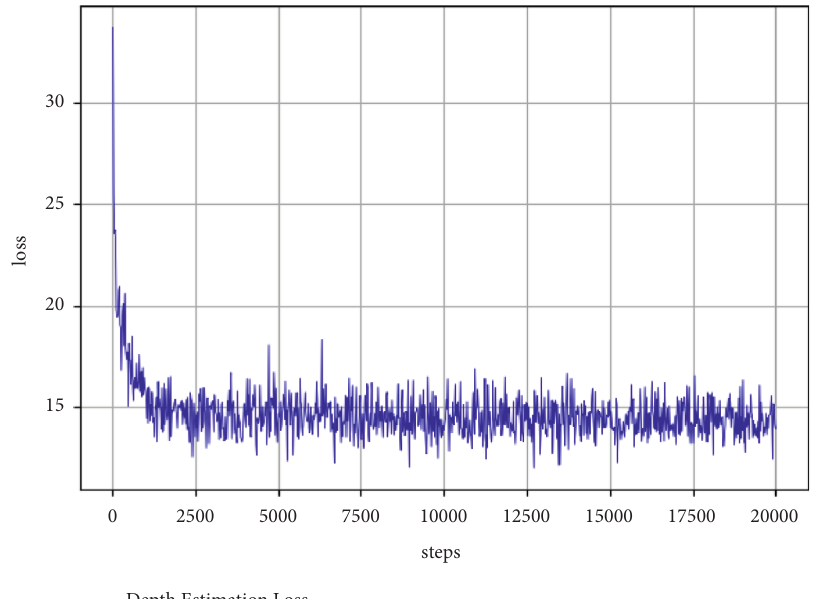
Figure 9: Loss change of depth